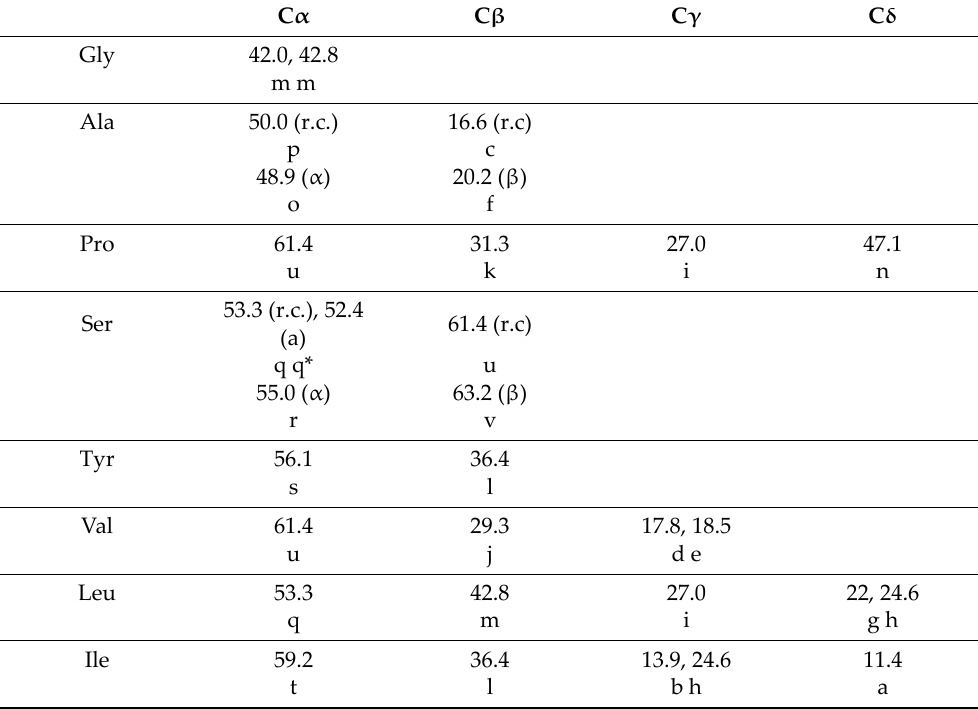
Table 1. 13 C solid‑state NMR chemical shifts (ppm) of RSSP(VLI) powder and